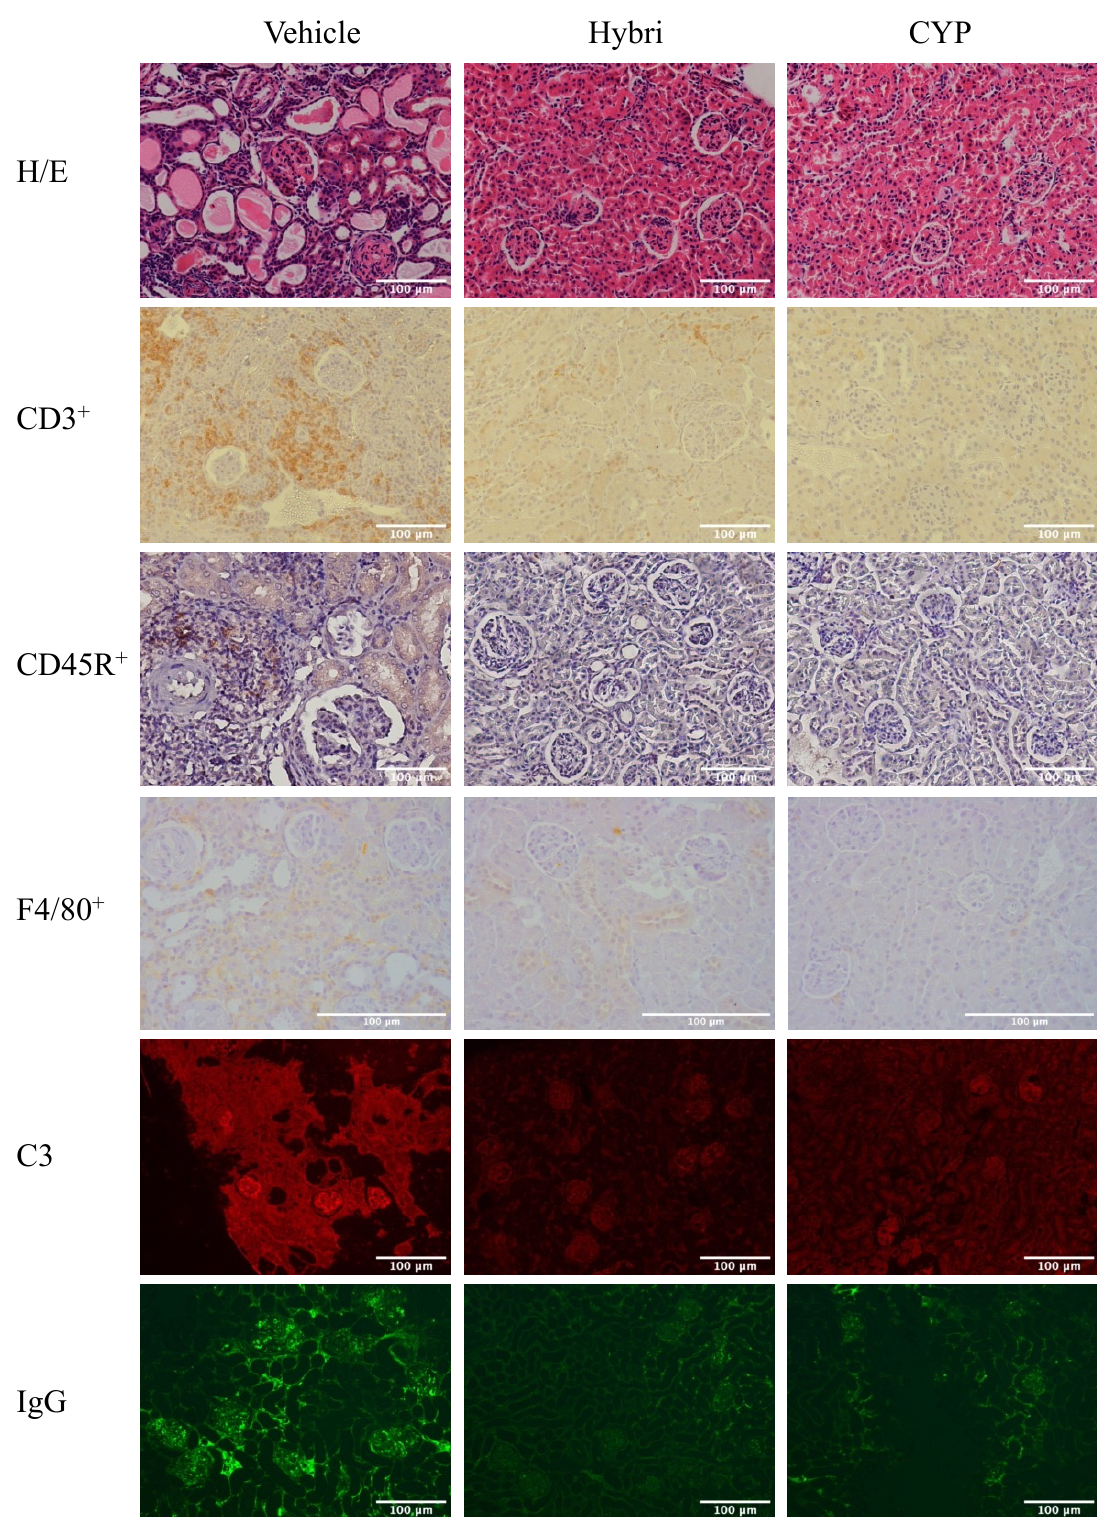
Figure 7. Effect of different treatments on the kidneys in the MRL/lpr study. Representative histo- logical images of hematoxylin and eosin staining and CD3 + , CD45R + , and F4/80 + infiltrate using im- munohistochemistry. Immunofluorescence images of C3 and IgG deposition.